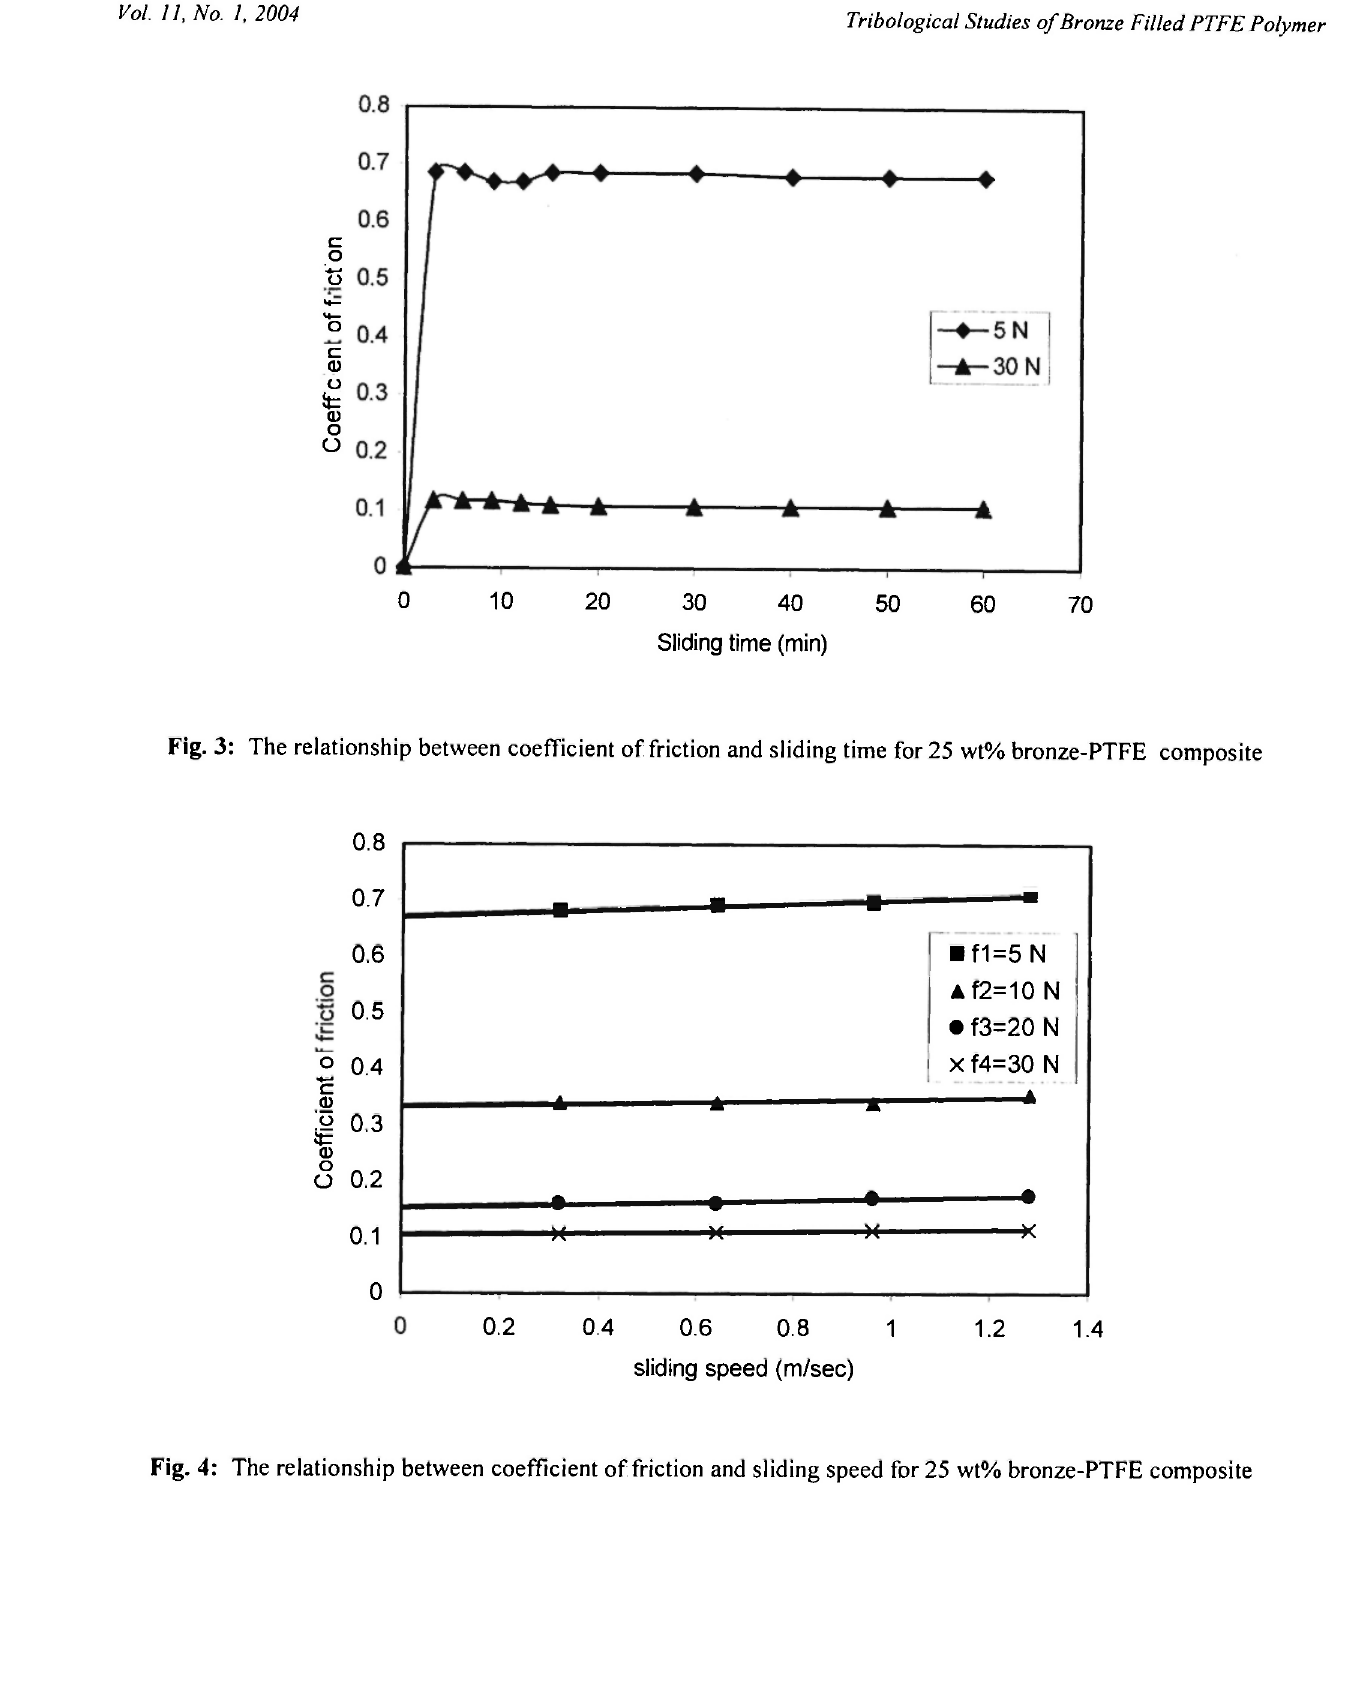
Fig. 4: The relationship between coefficient of friction and sliding speed for 25 wt% bronze-PTFE